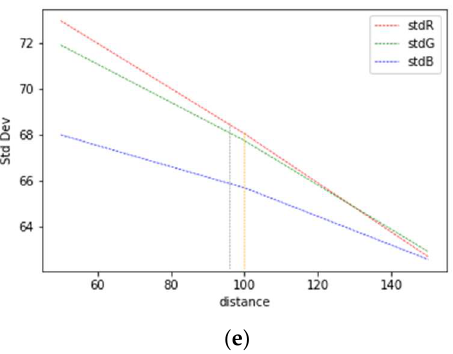
Figure 7. Primitive mask for vehicle dataset. ( a ) 50 cm pixel distribution and mask, ( b ) 100 cm pixel distribution and mask, ( c ) 150 cm pixel distribution and mask, ( d ) full-size pixel distribution and mask, ( e ) graph of standard deviation of RGB pixel values vs. buffer distance.